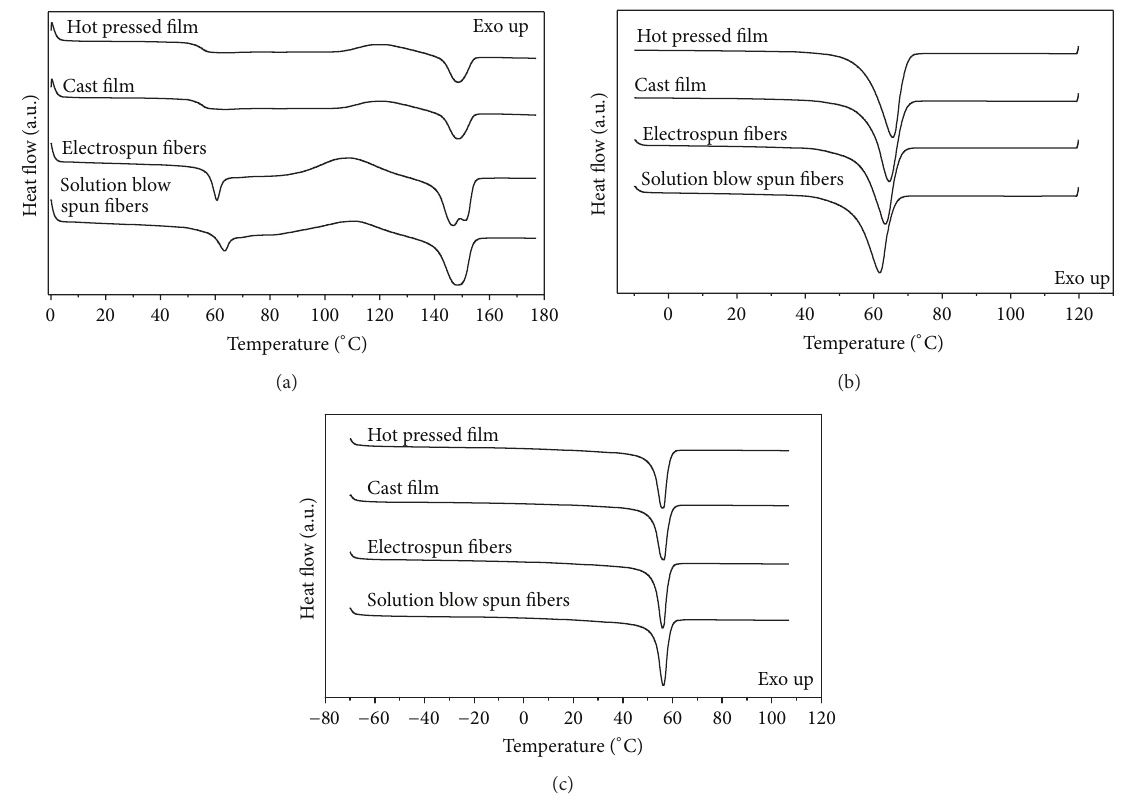
Figure 7: DSC curves for (a) PLA, (b) PEO, and (c)